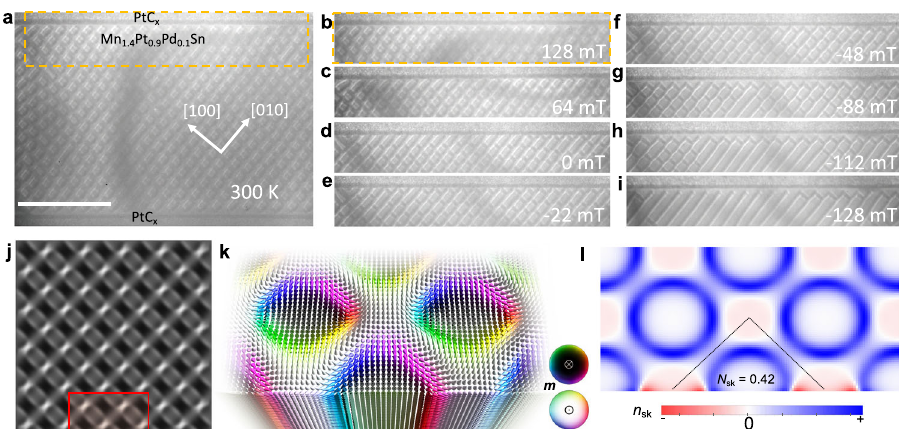
Fig. 1 Formation of fractional antiskyrmions at an interface of Mn 1.4 Pt 0.9 Pd 0.1 Sn. a The lamella is fi lled with a dense lattice of antiskyrmions and a few short helices at 128 mT and 300 K. The region marked by the dashed orange rectangle in ( a ) is shown for various magnetic fi elds in ( b – i ). Note that ( b ) is the same image as in ( a ). c Image in a fi eld of 64 mT. d Fractional antiskyrmions that form at the interface region with PtC x are elongated in the absence of a magnetic fi eld. e – f When a negative magnetic fi eld is applied, the fractional antiskyrmions become smaller in size. h , i At fi elds beyond − 100 mT, the antiskyrmions in the interior region fi rst join with each other and form helices and then these helices join with the fractional objects so that a helical state is also found at the interface. The scale bar in ( a ) corresponds to 2 μ m. j Simulated LTEM contrast of an antiskyrmion lattice with fractional antiskyrmions at the edge that was stabilized in micromagnetic simulations. k A magni fi ed view of the magnetic texture of the red area in ( j ) with arrows and colors indicating the orientations of the magnetic moments. l The topological charge density of the spin texture in ( k ).